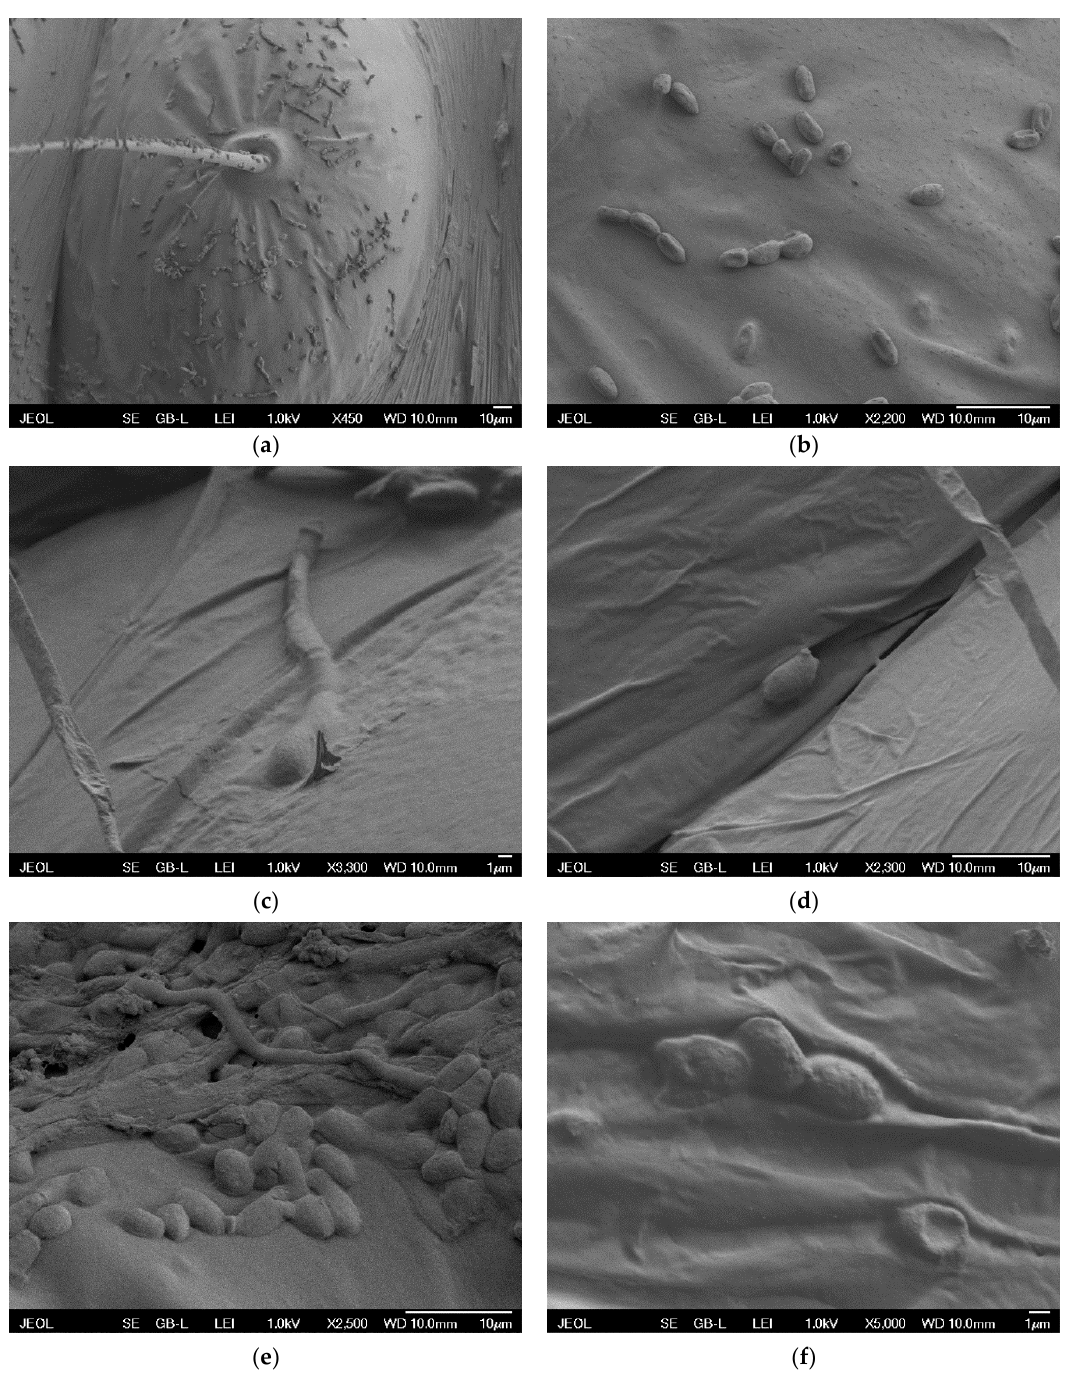
Figure 4. Low-temperature scanning electron microscope (LT-SEM) image of Isaria fumosorosea conidia on the cuticle of Cydalima perspectalis larva. ( a , b ) Conidia immediately after the fungus application; ( c ) Conidium with germ tube after 24-h incubation; ( d ) Ungerminated conidium after 24-h incubation; ( e ) Group of ungerminated conidia after 24-h incubation; ( f ) Ungerminated conidia after 48-h incubation.